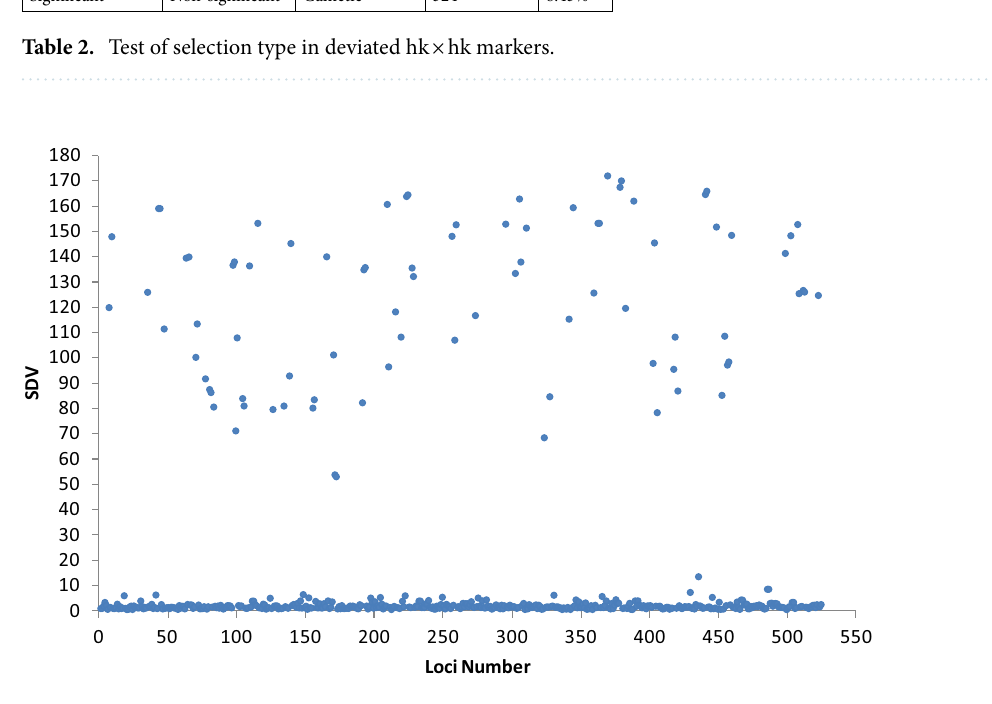
Figure 1. The SDVs of all gametic selection loci. Each dot indicates a marker suffering gametic selection and the ordinate value refers to its segregation distortion value (SDV). Most of them have low SDVs below 5, whereas approximate 15% of the gametic selection loci are distributed in the high SDV region of 60 ~